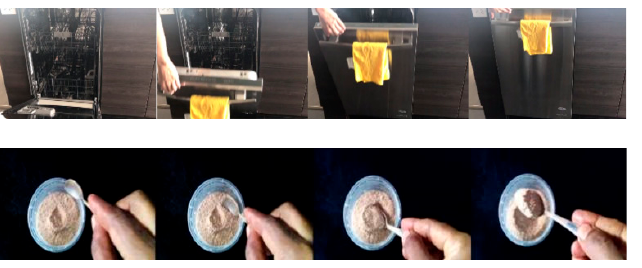
Figure 6. Example of actions in time-related datasets ( top ) closing the dishwasher; ( bottom ) scoop- ing a spoonful of powder). a spoonful of